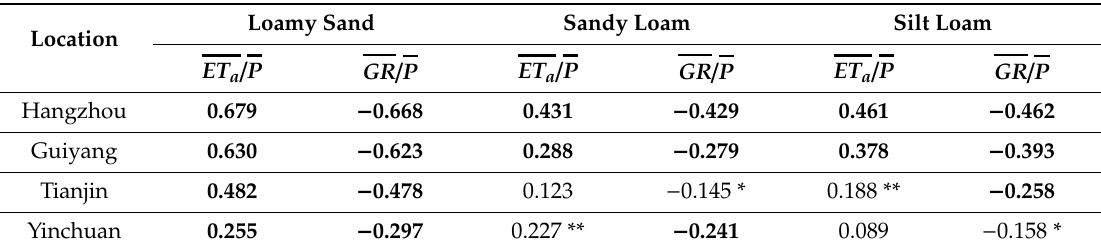
Table 4. Spearman’s rank correlation coe ffi cients of mean relative di ff erence ( MRD ) of soil moisture with mean annual ratios of actual evapotranspiration ( ET a ) and groundwater recharge ( GR ) over precipitation ( P ).